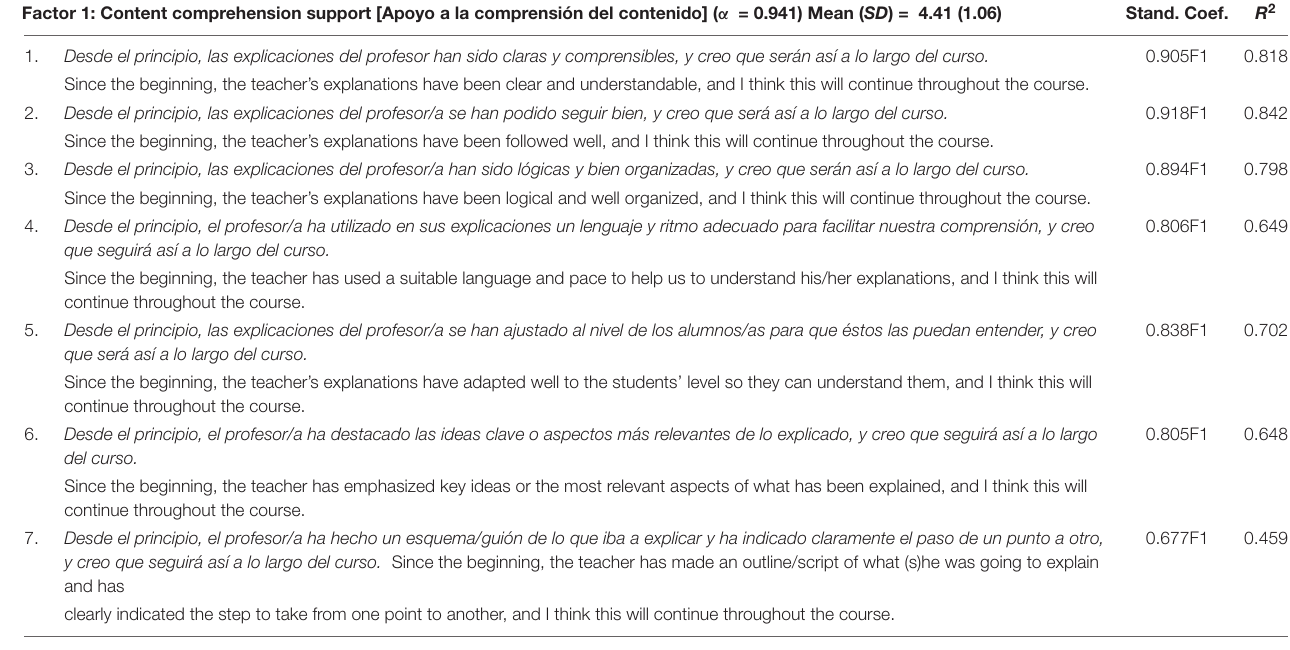
TABLE 3 | MOCSE-TSQ factor structure, items standardized coefficients and their contribution to the corresponding factor ( R- squared). Factor 1: Content comprehension support [Apoyo a la comprensión del contenido] ( α = 0.941) Mean ( SD ) = 4.41 (1.06) Stand. Coef. R